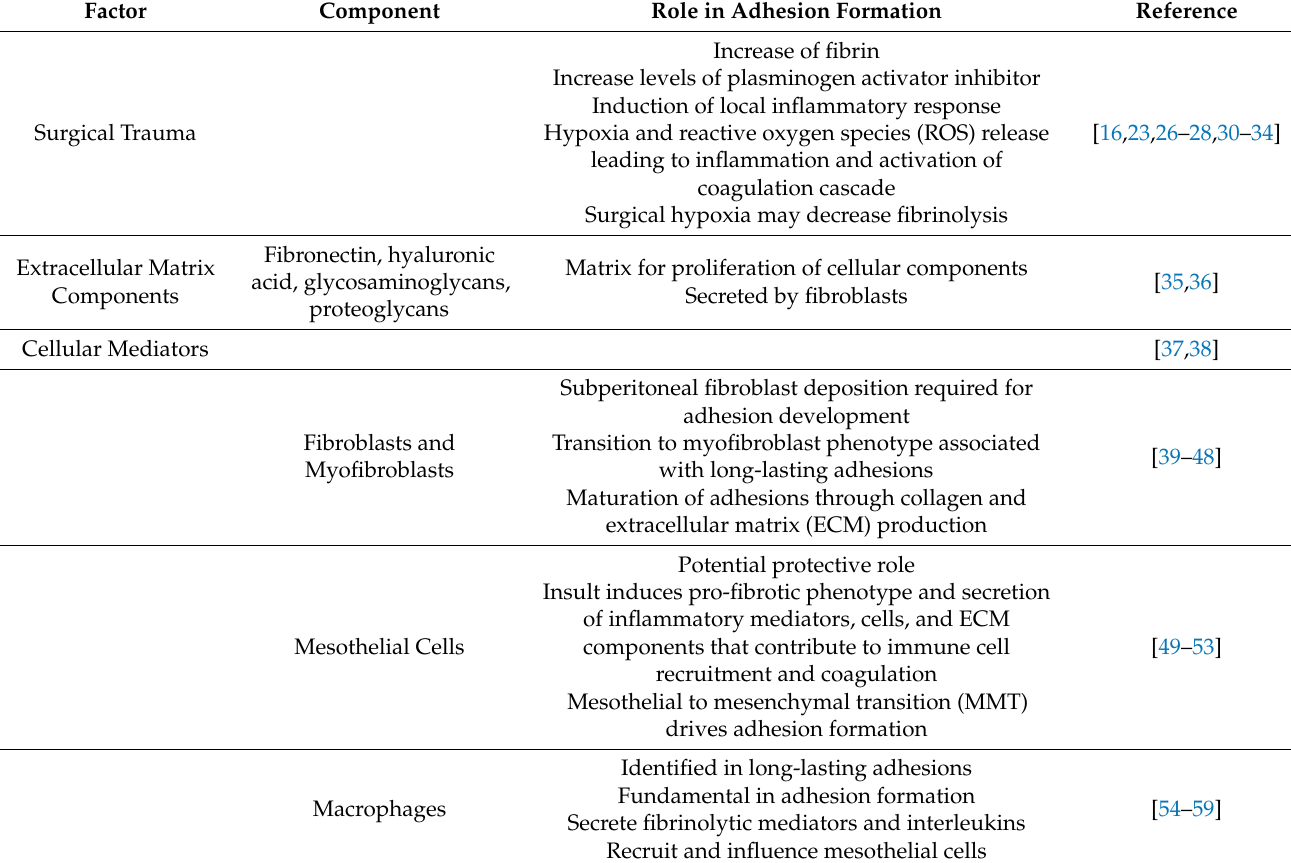
Table 1. Cellular and signalling pathways involved in adhesion